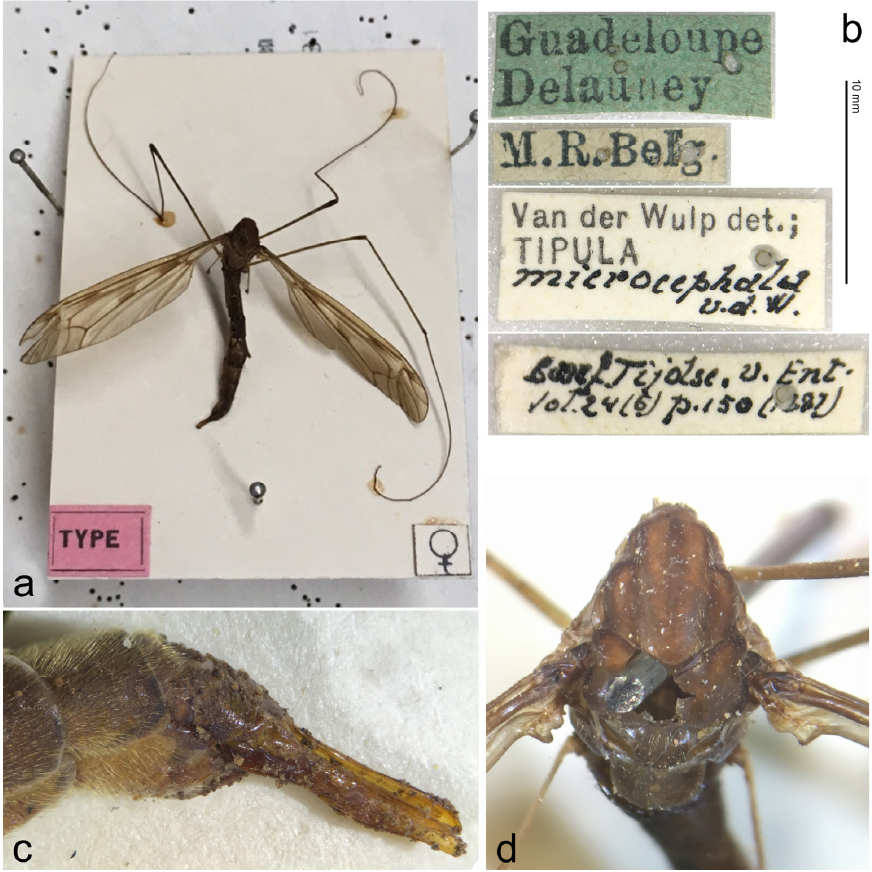
Figure 11. Zelandotipula parviceps (Speiser, 1909), holotype female; ( a ) Habitus; ( b ) Type labels; ( c ) Ovipositor, lateral view; ( d ) Thorax, dorsal view.